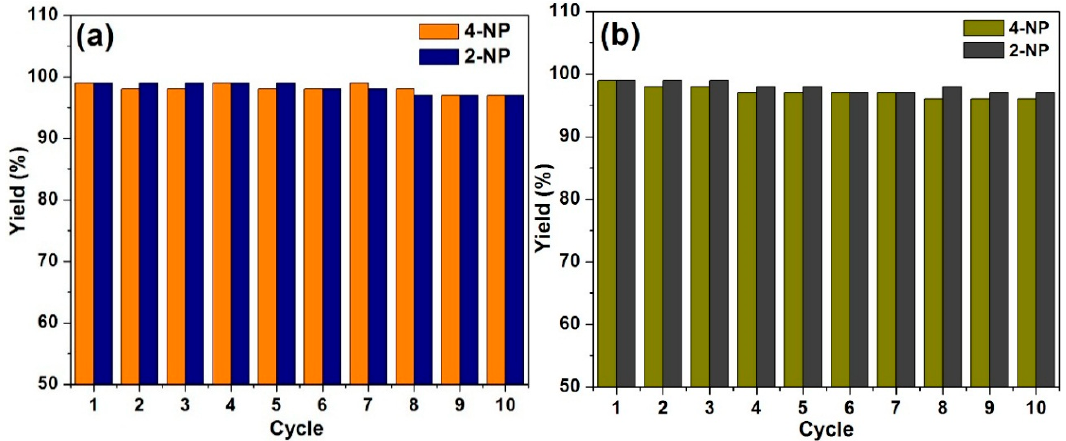
Figure 11. Reusability test of ( a ) Ni/GO-1 and ( b ) Ni/GO-2.